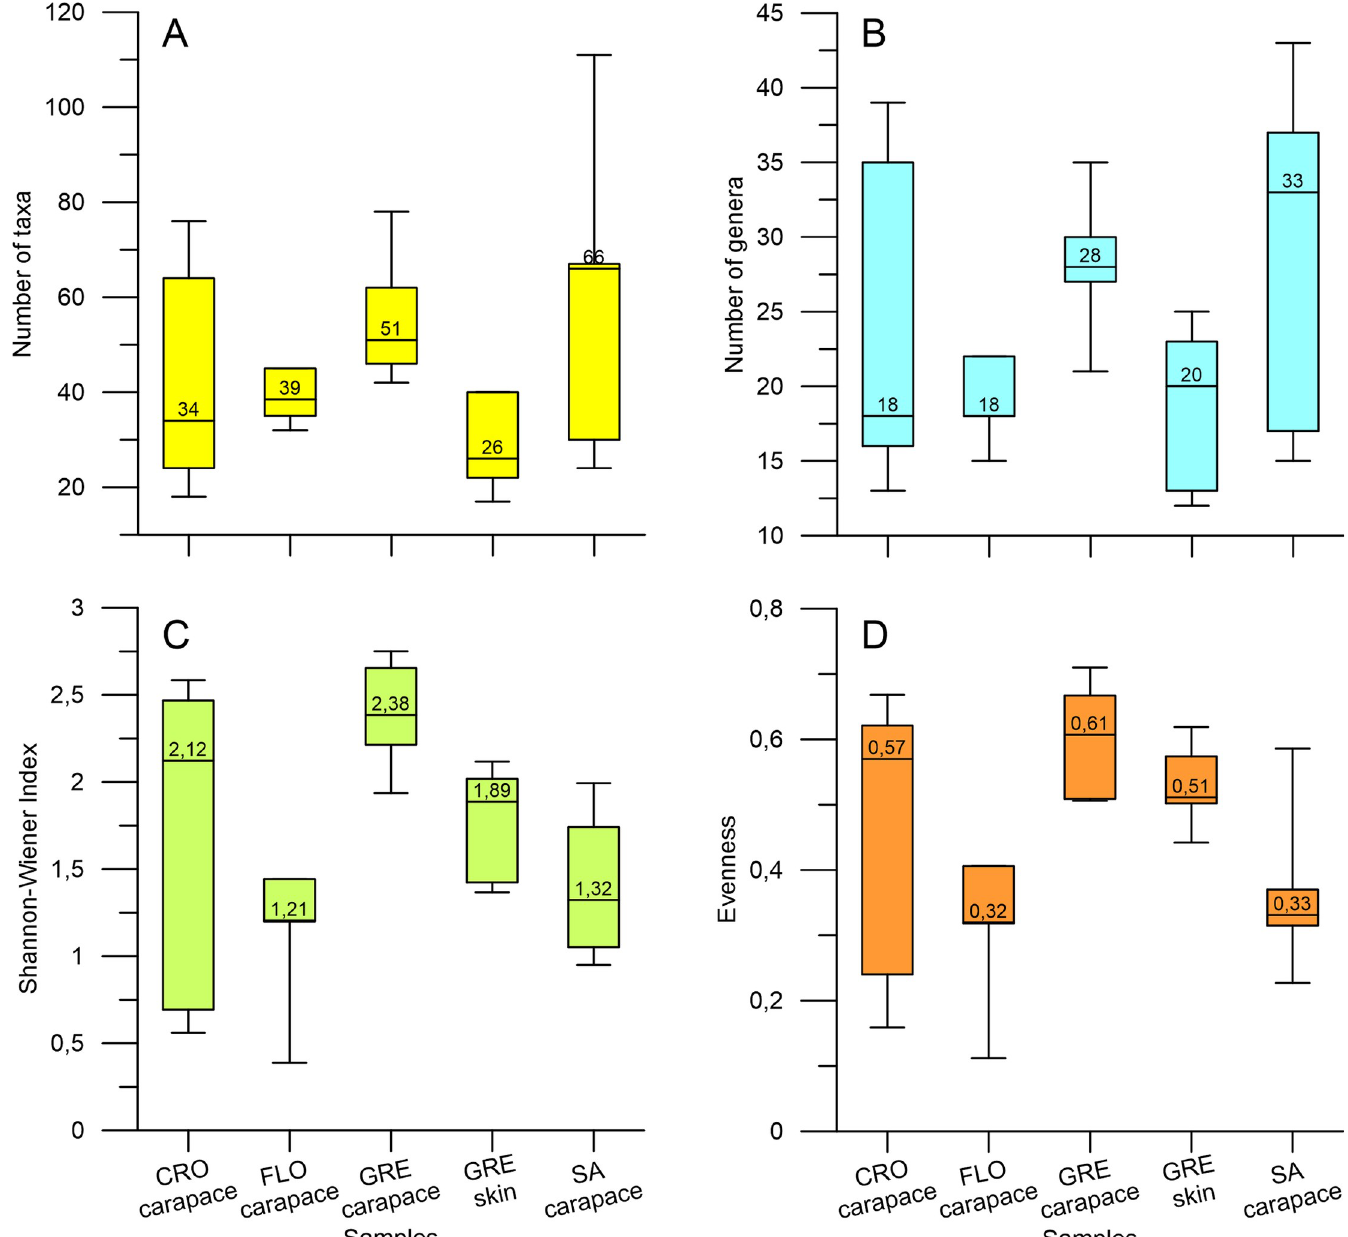
Fig 4. Box and whisker plots of diatom community diversity across localities. The diatom community diversity for loggerhead carapace samples from every locality, and the skin samples from Greece. (A) The number of taxa. (B) genera, (C) the Shannon-Wiener diversity index and D) evenness. Whiskers indicate maximum and minimum, the median value is denoted within the box. CRO = Croatia, Adriatic Sea; FLO = Florida Bay, USA; GRE = Greece, Amvrakikos Gulf; SA = South Africa, Kosi Bay.